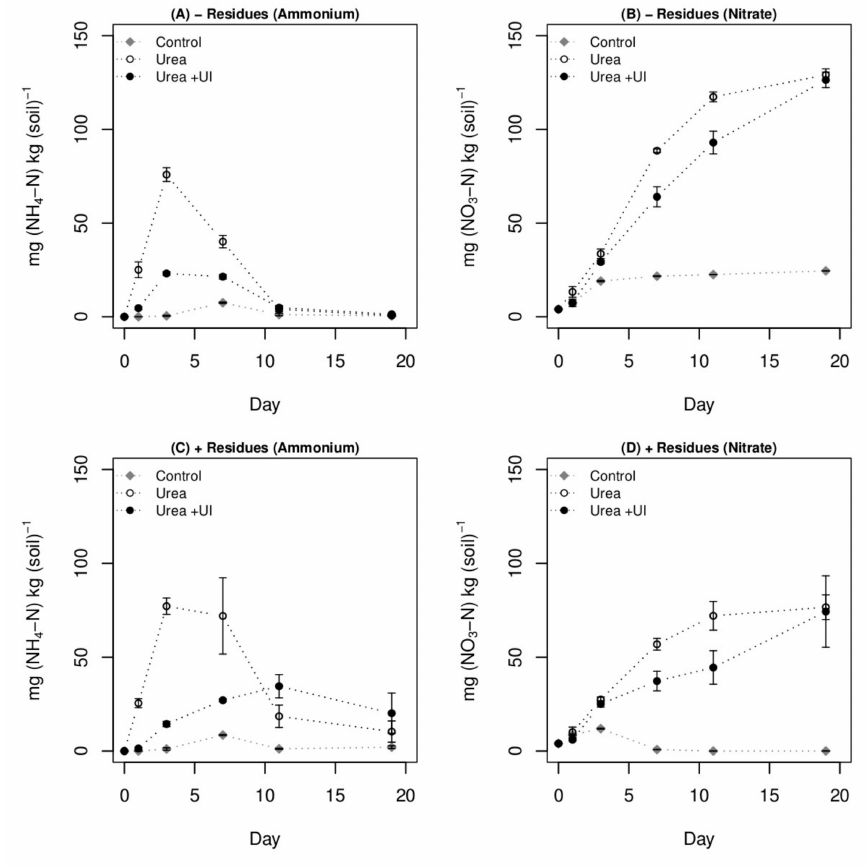
Figure 1. Turnover of ammonium-N ( A , C ) and nitrate-N ( B , D ) in alkaline soil of the North China Plain (NCP) after application of urea and urea + UI ( N -(n-butyl) thiophosphoric triamide (NBPT)) without ( A , B ) and with ( C , D ) incorporated residues (wheat straw). Error bars indicate the standard errors of the